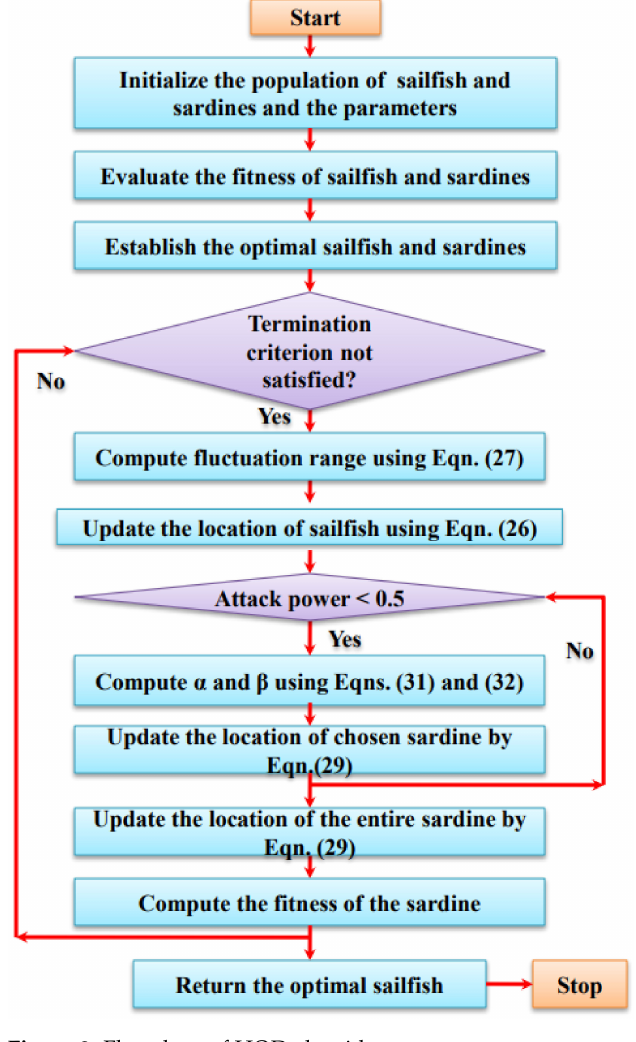
Figure 2. Flowchart of HOD